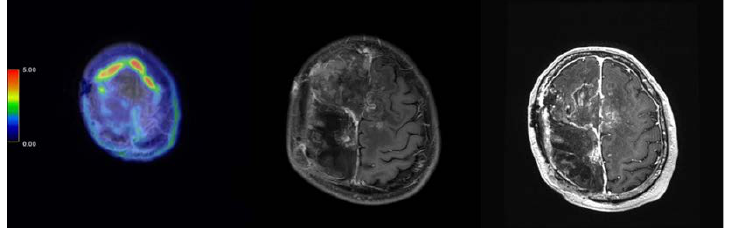
Figure 3. MRI image of case 191 with skull base meningioma. ( Left ) Pre-BNCT, FBPA-PET image. ( Middle ) Pre-BNCT, axial MRI with contrast. ( Right ) Three months after BNCT, axial MRI with contrast.